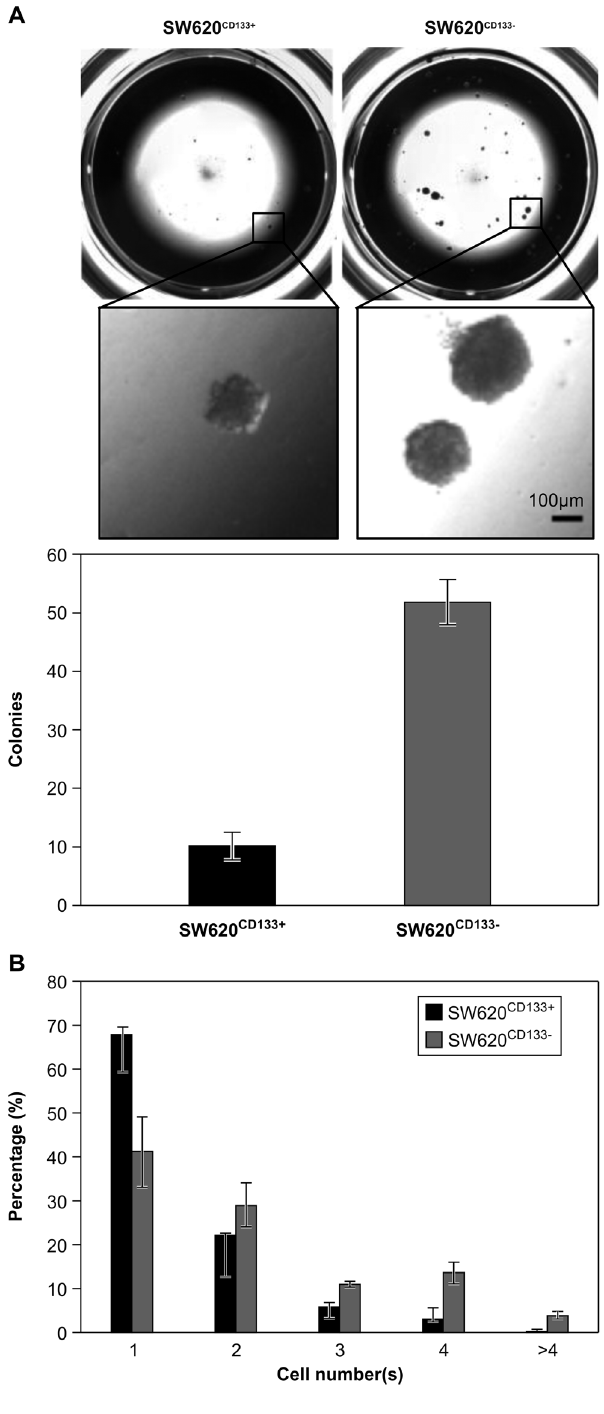
Figure 2. Comparison of colony formation capacity of SW620 CD133 + and SW620 CD133 2 cells on 3D Matrigel culture. Purified SW620 CD133 + and SW620 CD133 2 cells were seeded on top of Matrigel for further analysis of cell proliferation and colonization. (A) Upper panel shows the entire and enlarged picture for colonies morphology; lower panel shows colonies count after 3 weeks of incubation. The SW620 CD133 + cells formed a mean of 10 colonies (SD=2.2) and the SW620 CD133 2 cells a mean of 50 colonies (SD=3.8). Bar=100 m m. (B) Cell count after 3 days of incubation.